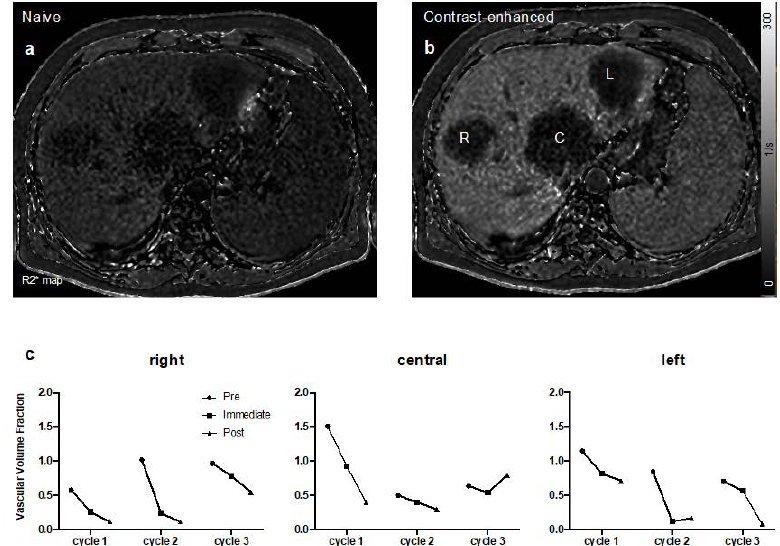
Figure 5. Early evaluation of tumor perfusion response to tTF-NGR using R2* mapping in MRI: R2* maps before ( a ) and after ( b ) injection of the iron-based contrast medium Resovist ® visualize the perfusion of 3 liver metastases (R = right, C = central, and L = left) of a patient with a colorectal carcinoma (UPN 007). The calculated vascular volume fractions (VVF) demonstrate a reduction in blood flow after treatment with tTF-NGR for each of the 3 cycles ( c ) at 3 (cycle 1), 4 (cycle 2), and 5 (cycle 3) mg / m 2 tTF-NGR per day × 5. Notice the partial reperfusion at the beginning of cycles 2 and 3. ( c ) y-axis shows arbitrary units, black circles represent measurements before (pre) treatment with tTF-NGR, black squares are 5 h (immediate) after tTF-NGR, and black triangles are after 5 days (post) of tTF-NGR at the end of a cycle.